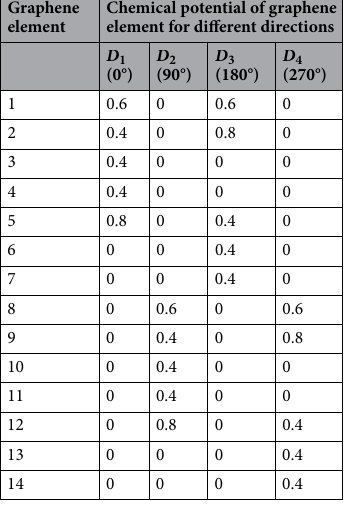
Table 4. Condition for different main beam direction.